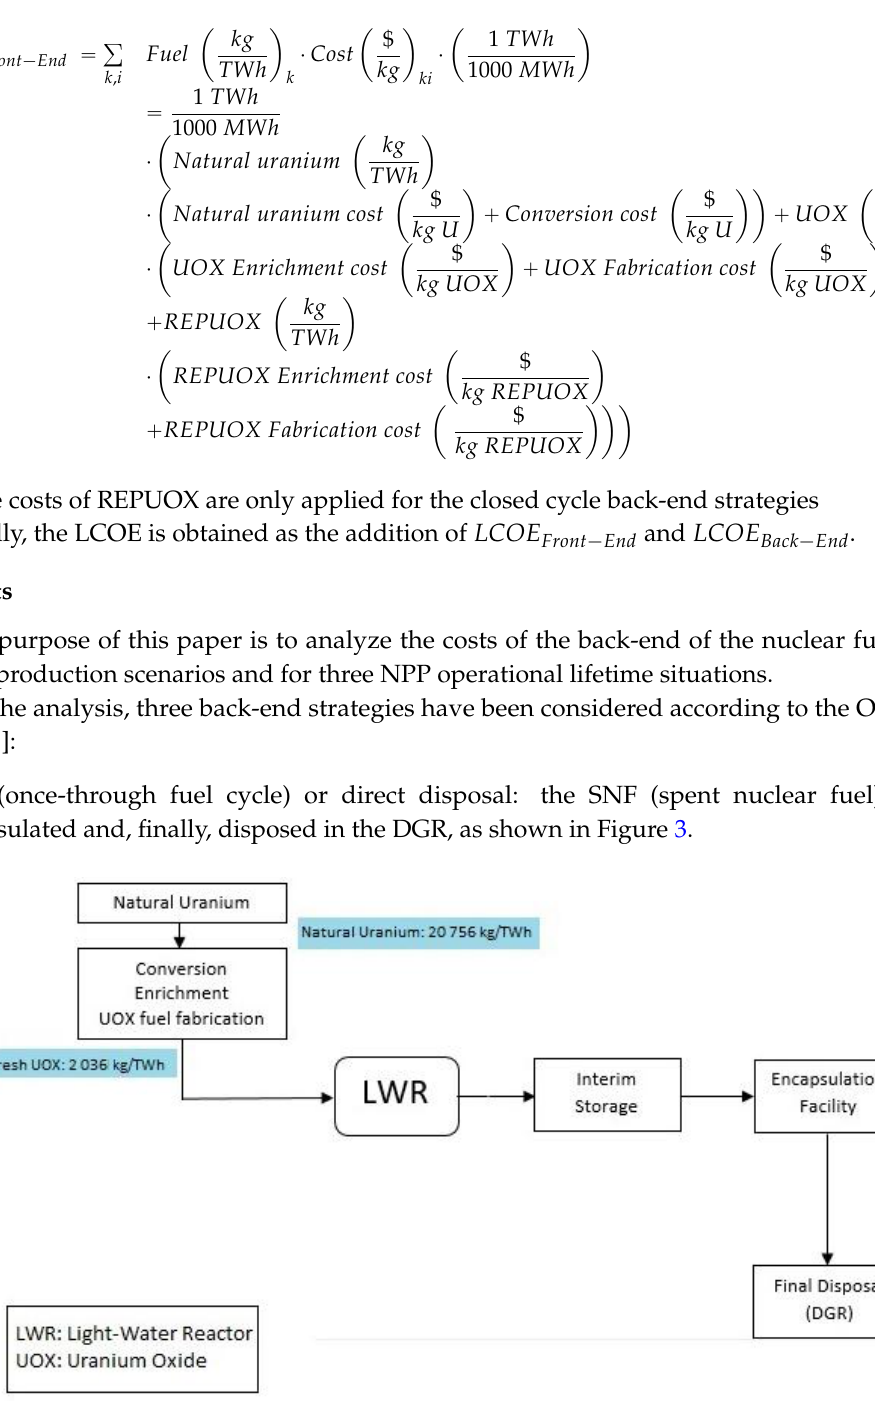
Figure 3. Once-through fuel cycle. UOX, uranium Figure 1. Once-through fuel cycle. UOX, uranium oxide.